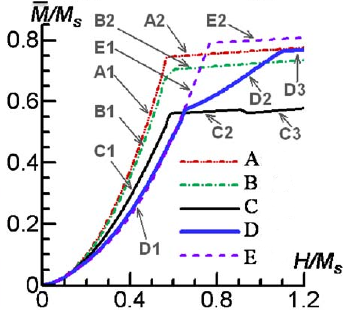
Figure 3. Simulated magnetization curves from article [21]. In this work, the angles between the applied magnetic field and the x axis were set in contrast of our case. If we consider the angles between this field and the y axis, then the curves will correspond to the following angles: A—90 ◦ , B—70 ◦ , C—45 ◦ , D—20 ◦ , E—0 ◦ . A1, A2 are the sections of the curve A; B1, B2 are the sections of the curve B and so on. These curves are given to qualitatively confirm the correctness of the results presented in Figure 2, and are discussed after discussing the curves in Figure 2.